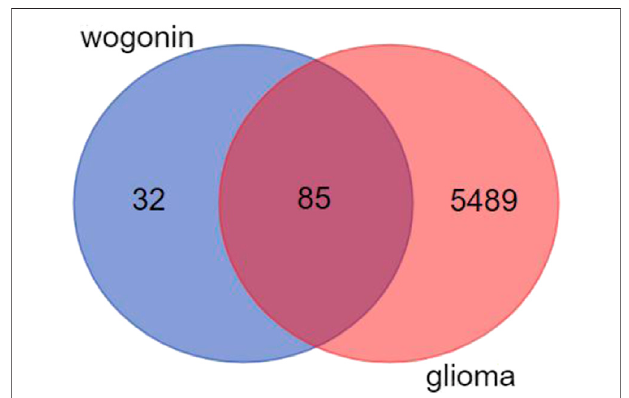
FIGURE 2 | Venn diagram of drug targets and disease